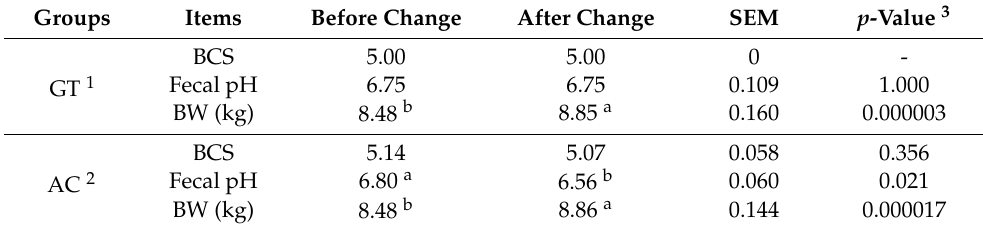
Table 3. Effects of different dietary change methods on BCS, fecal pH, and total BW. Groups